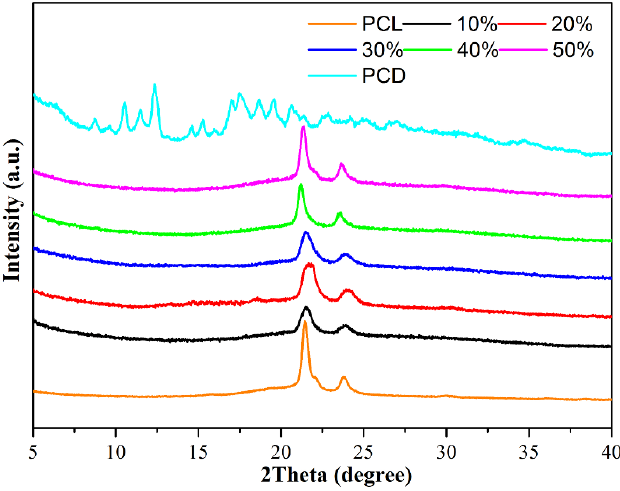
Figure 4. XRD patterns of the prepared neat PCL fibers and composite fiber composites.